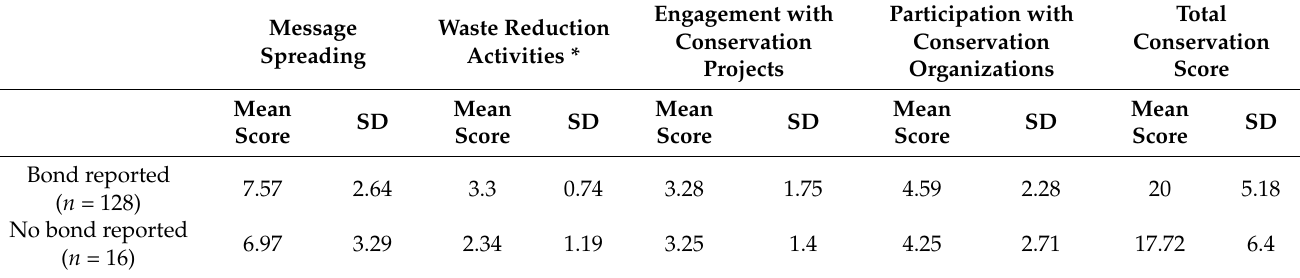
Table 2. Mean conservation scores for each group of behaviors and the total conservation scores for keepers who reported a perceived bond with an animal and keepers who did not. An asterisk denotes a statistically significant difference was found in this